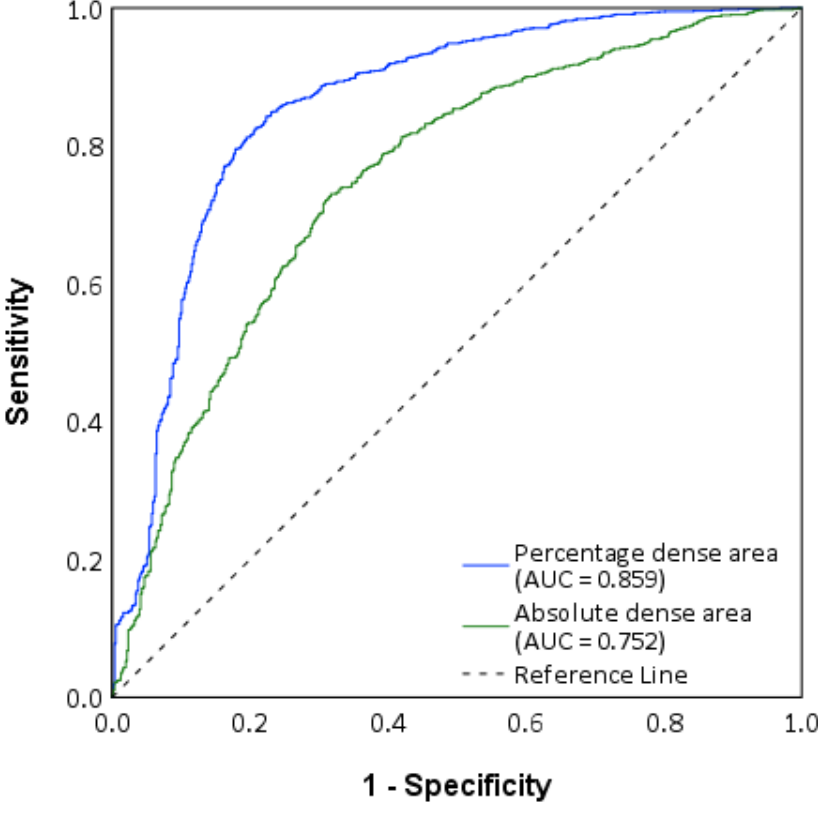
Figure 4. The receiver operating characteristic (ROC) curve for sensitivity and specificity of determining the absolute dense area and percentage dense area in discriminating dense from fatty breasts. AUC, area under the ROC